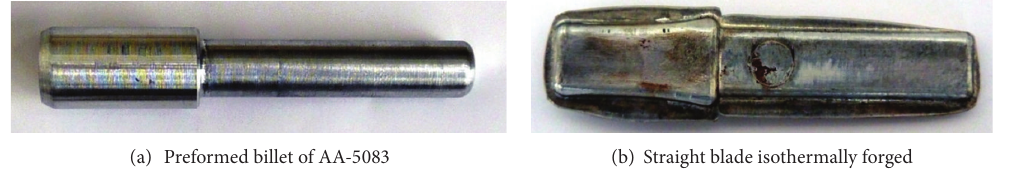
Figure 2: Shape of the preformed billet and the manufactured straight blade.